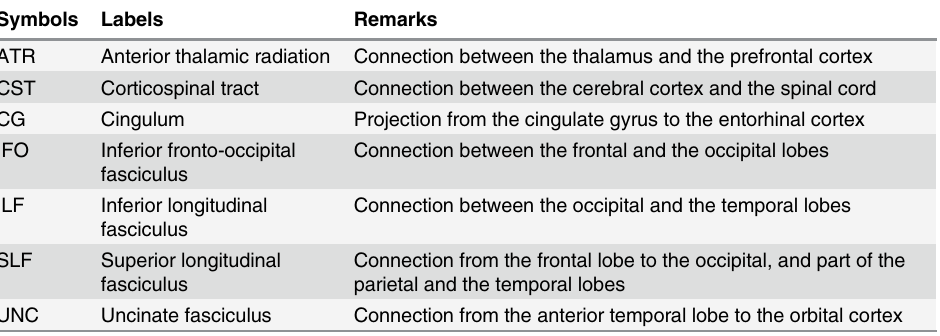
Table 1. Major anatomic bundle